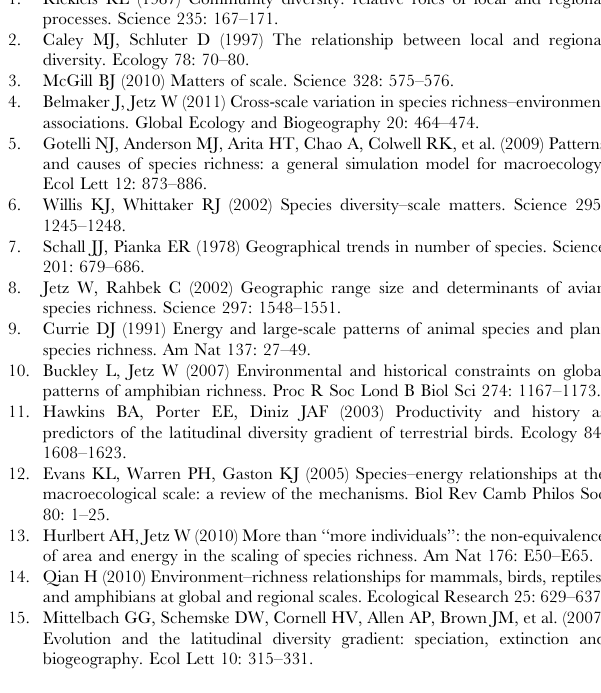
Table S7 Predictors of bioregion richness for Endotherms (mammals + birds) and Ectotherms (amphibians + reptiles) with details on slope estimates. Species richness values and all predictors except temperature were ln-transformed; temperature is given as 1/kT (where k is the Boltzmann constant). For other details see Table 1. Table S8 Predictors of bioregion richness. Results for all taxa. For other details see Table 1. Table S9 Comparison of AIC values of alternative formulations of models combining the effects of TimeArea and Productivity , and of TimeArea , Productivity , and Temperature on bioregion species richness. TimeArea and Productivity are either integrated into a single variable ( TimeAreaProductivity , see Figure 1), modeled additively, or modeled as an interaction. Models with . 3 units AIC larger than the model with the smallest AIC within a group (i.e., significantly worse) are marked in bold. Table S10 Comparison of AIC values of TopoRange (log(max- imum 2 minimum elevation) in a bioregion) as an alternative predictor of bioregion species richness. Null model is fitting the intercept only. The variable Area , which is correlated with TopoRange (r Spearman = 0.58, N = 32), offers either equal or better fit. Table S11 Spearman rank correlations among Total , Resident , and Endemic richness for different taxa across 110 km quadrants ( N =9,253). For richness definitions, see Table S2. Table S12 Prediction success ( r 2 ) of bioregion-level models of Total and Resident richness of 110 km grid cell assemblages ( N =9,253) based on general linear models. Grid cell richness is